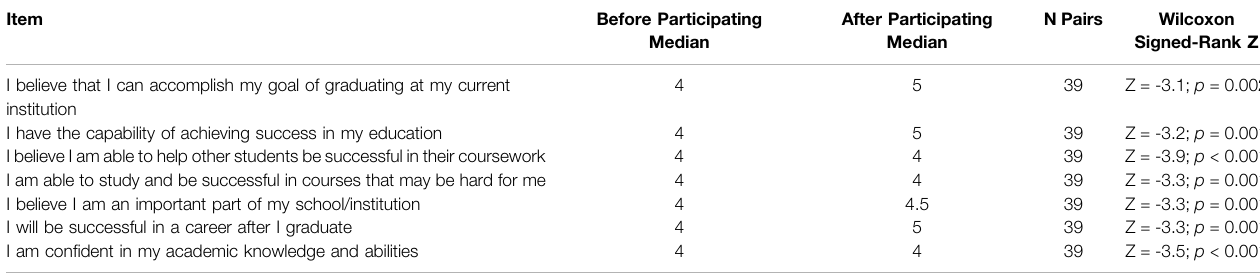
TABLE 4 | Analysis of Survey items related to Academic Self-Concept. Item